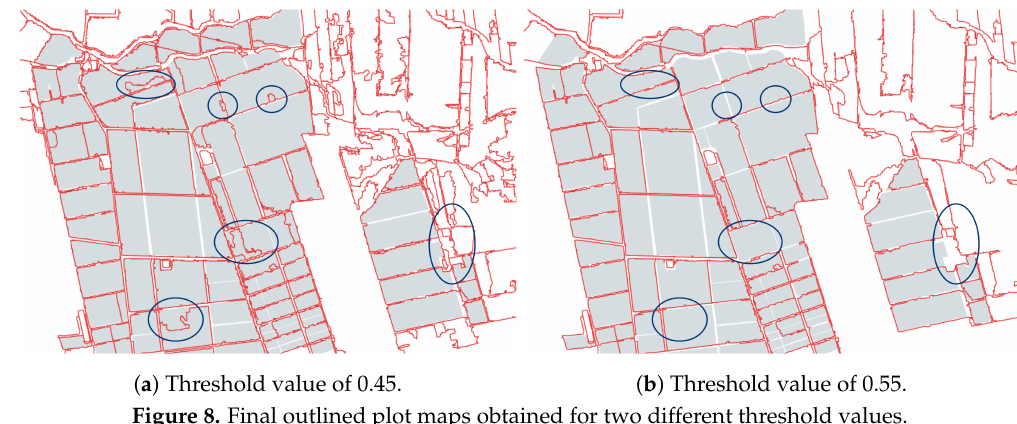
Figure 8. Final outlined plot maps obtained for two different threshold